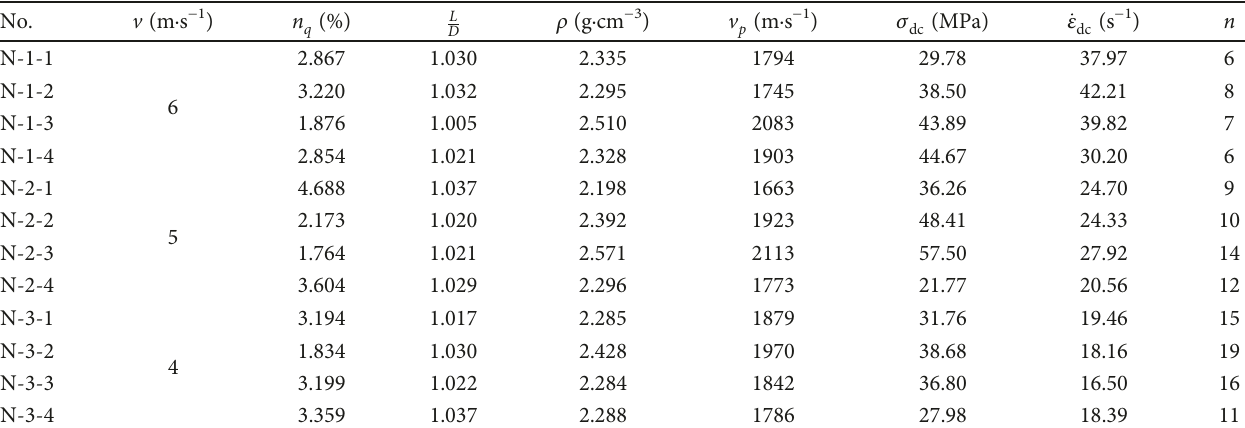
Table 3: Constant-velocity cyclic impact test